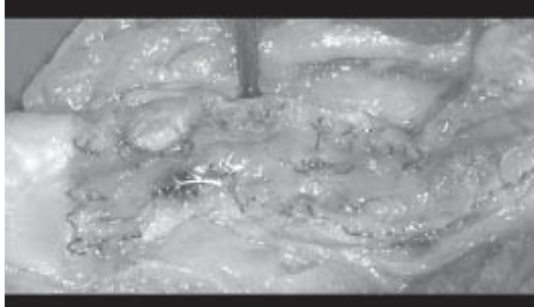
Fig. 5 - Incomplete endothelial development of the coronary artery after conventional stent implantation.